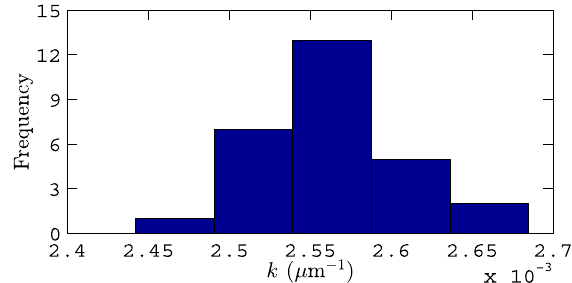
FIG. 19. Illustrative distribution of measured values of k for a given processor connected to a given BPM, recorded over a 20-month